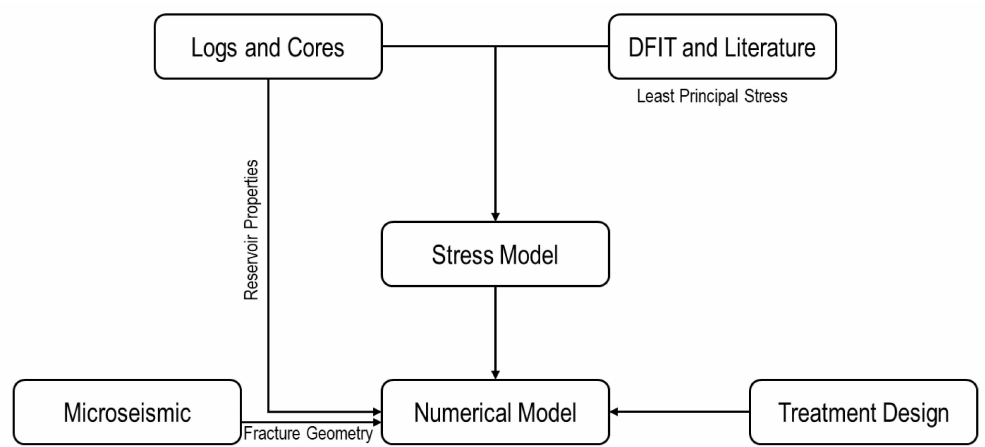
Figure 2. Schematic of the methodology and workflow used for the representative numerical